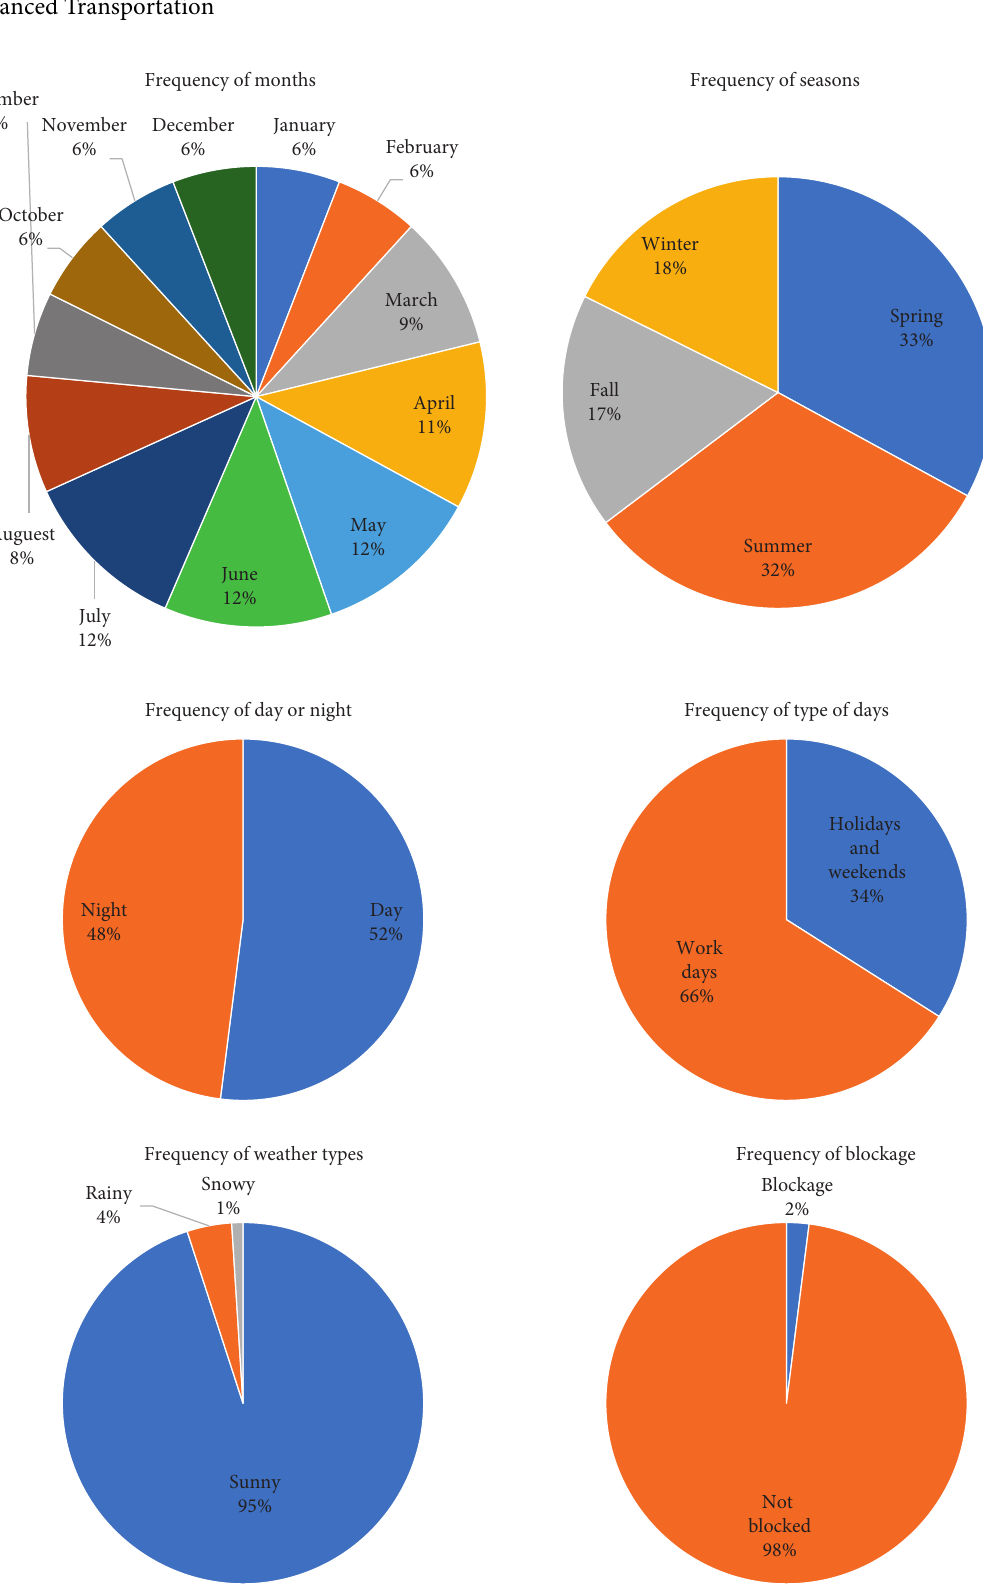
Figure 2: Characteristics of candidate